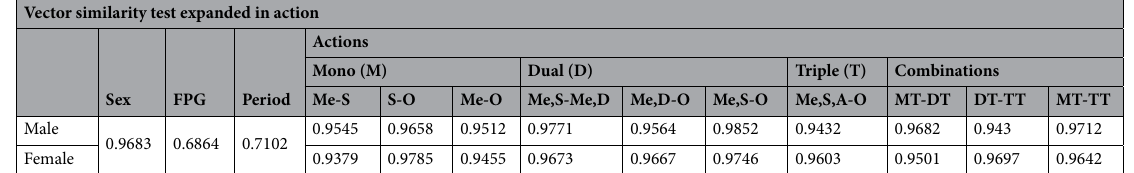
Table 3. Vector similarity test between gender, states, and actions. Me: metformin; S: sulfonylureas; D: DPP4- inhibitors; A: alpha glucose inhibitor; O: others; MT: mono therapy; DT: dual therapy; TT: triple therapy.